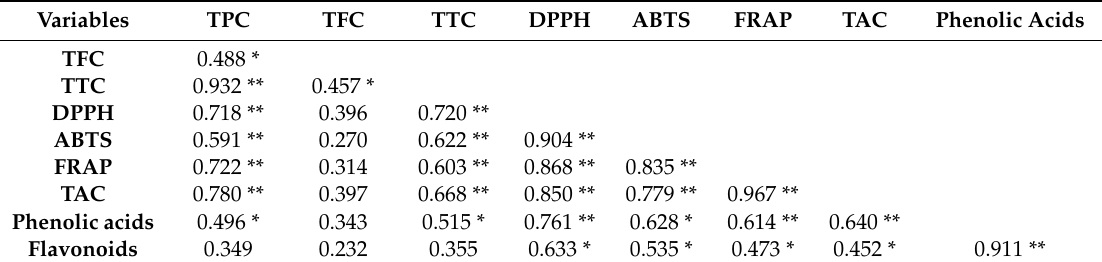
Table 4. Pearson’s correlation coe ffi cients (r) between phenolic content (TPC, TFC, TTC, phenolic acids, and flavonoids) and antioxidant activities (DPPH, FRAP, ABTS, and